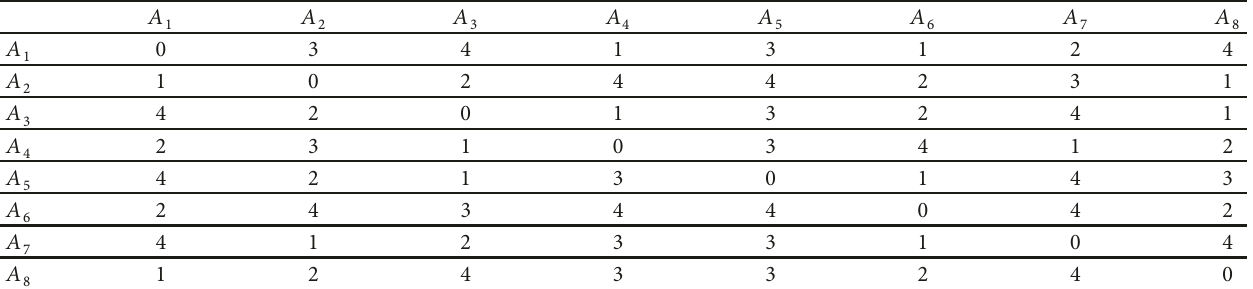
Table 3: Direct influence matrix